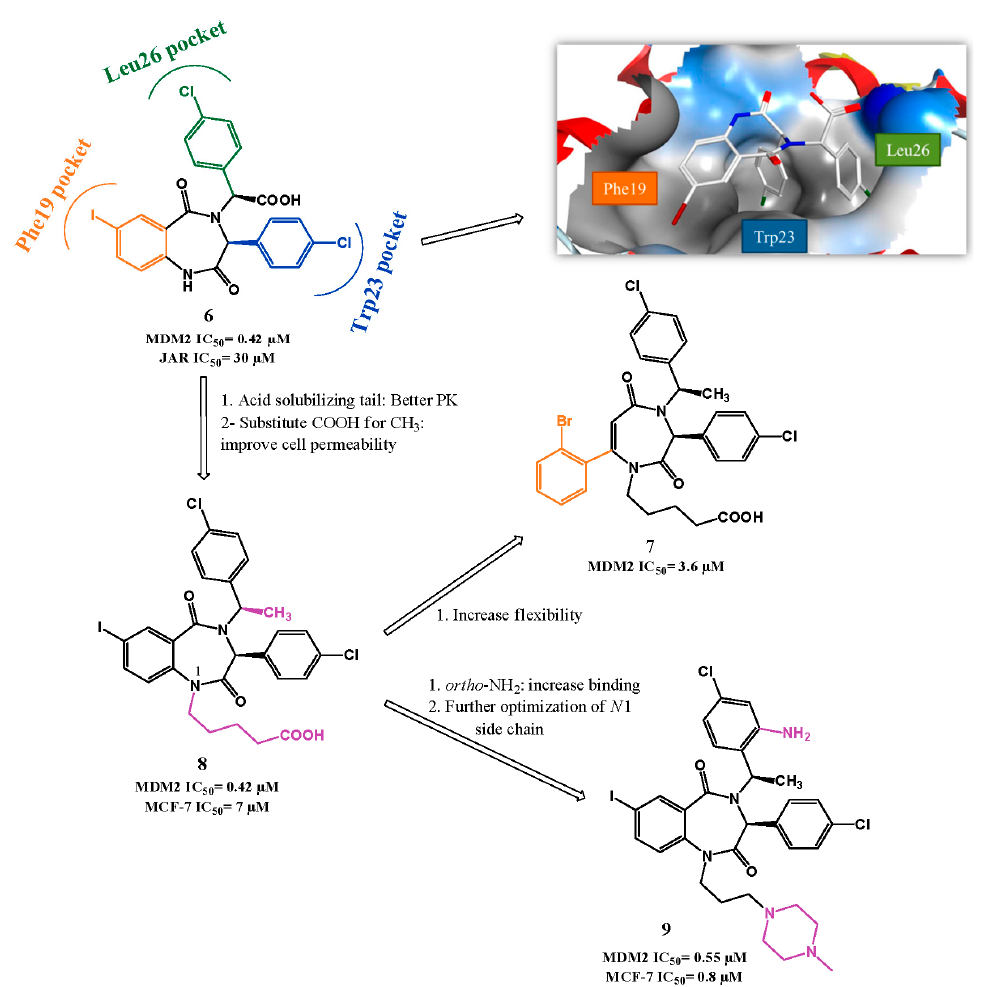
Figure 3. Benzodiazepinediones scaffold optimization. Right upper quadrant: crystal structure of compound 6 bound to MDM2 (PDB 1T4E). MDM2 surface is colored in blue for hydrophilic areas and grey for hydrophobic areas. Compound 6 is depicted in stick model and is colored according to element type: white for carbon atoms, blue for nitrogen atoms, red for oxygen atoms, dark red for the iodine atom, and green for chlorine atoms.